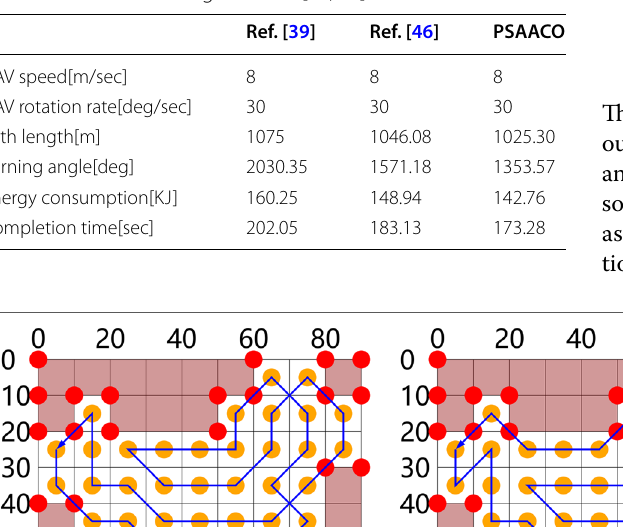
Table 11 Experiments on area 2 for performance comparison between PSAACO and algorithm in [39, 46]